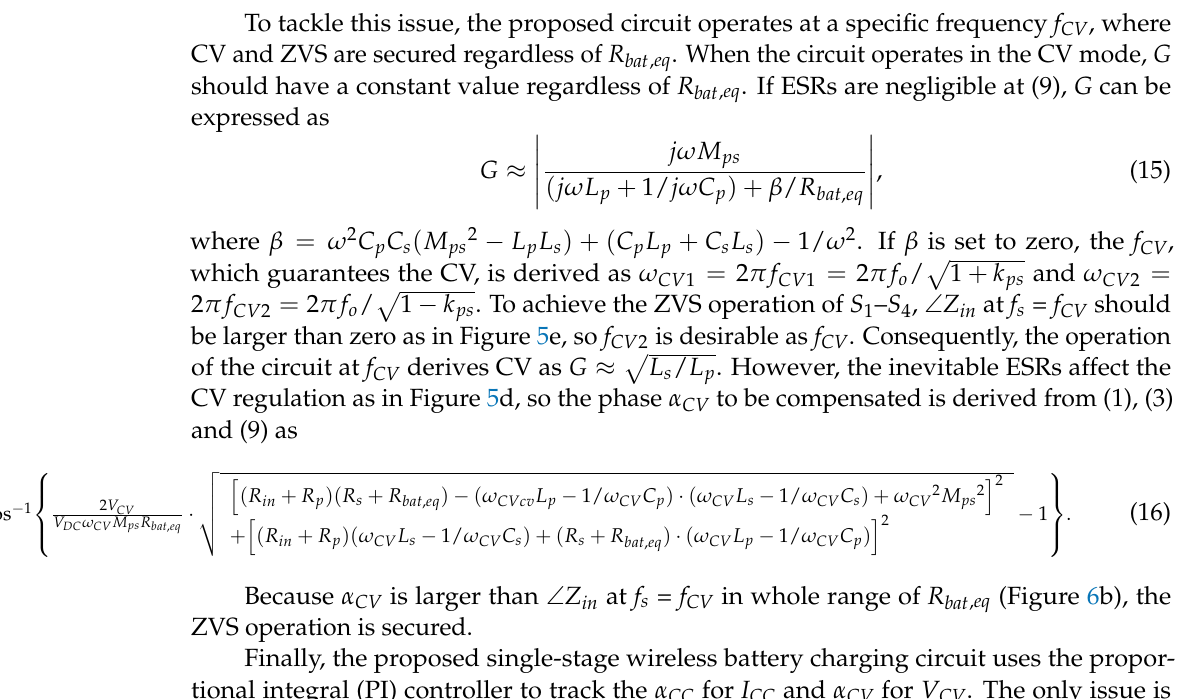
in and α cv , o at f s = f o , ( b )